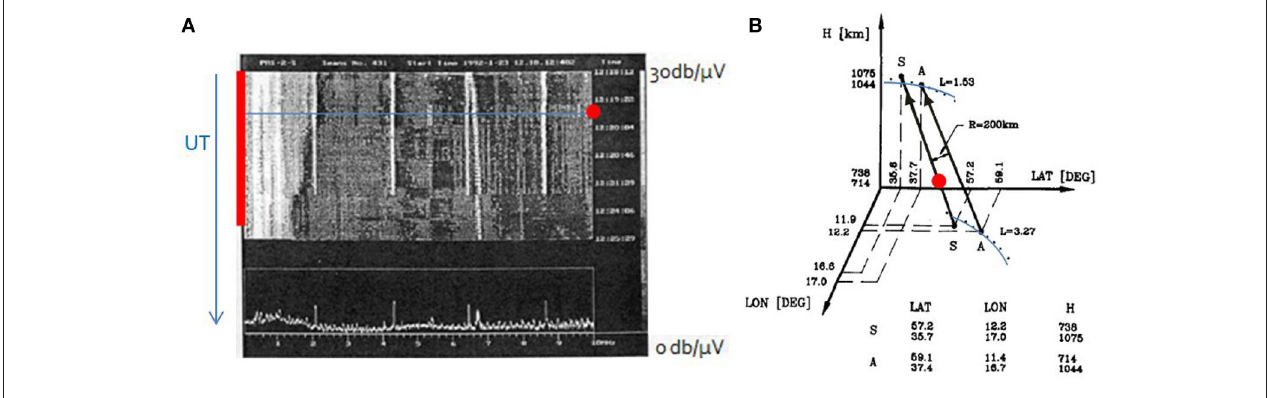
FIGURE 12 | HF waves registered onboard MAGION–3 durin the electron beam emission from IK–25. (A) Shows a sequence of radio spectra (PRS-2-S, vertical axis for time) along the orbit 0431. Emission intensity from black 0 dB /µ V to white 30 dB /µ V with nine equidistant levels. During the IK–25 electron beam injection (marked with the red bar) spiky emissions at ∼ 2.1 MHz and harmonics were registered. Bottom plot represents a single spectrum (12:19:37 UT, blue line cut). (B) Displays the relative position of the IK–25 satellite (A) and MAGION–3 (S) in the geographic coordinates. Their relative distance during injection was about 200 km . The dotted lines present the geomagnetic field lines. The injection started at 12:18 UT (altitude 714 km) and finished at 12:24:30 UT (alt. 1,044 km ). The red dots (both panels) mark the electron burst reported by Prech et al. (2002) in MAGION–3 data. (Reprinted from Rothkaehl et al., 1995, with permission from